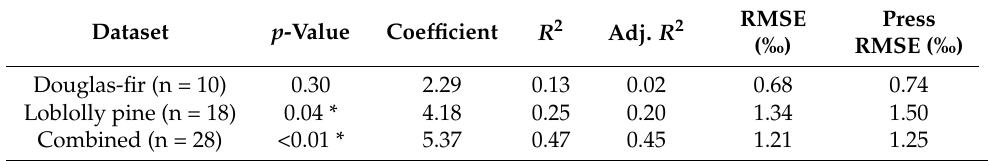
Table 3. Linear regression models using foliar nitrogen concentration (%N) to predict natural abundance foliar δ 15 N (‰) in Douglas-fir, loblolly pine, and a combined data set of both species. An asterisk (*) indicates model significance at the α = 0.05 level.